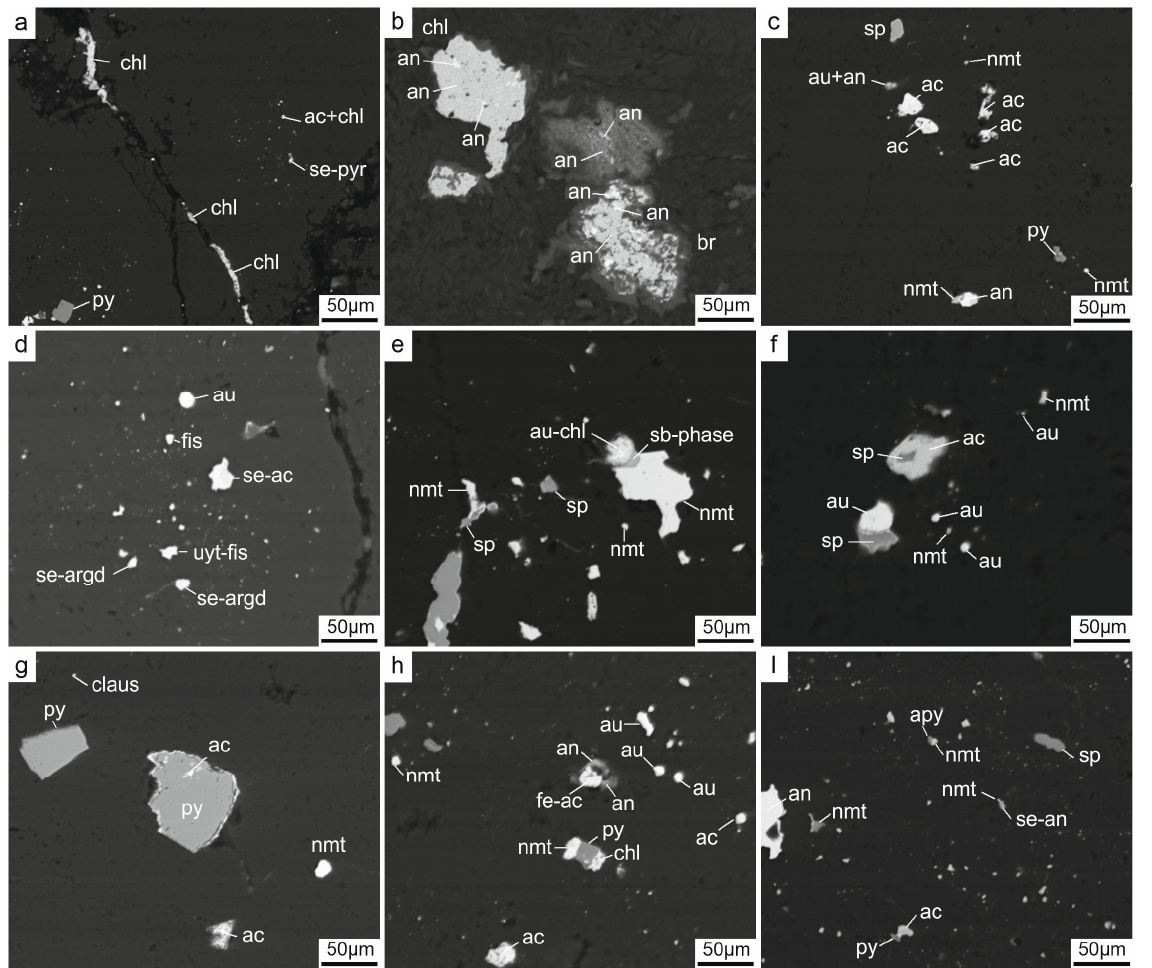
Figure 4. BSE (Backscattered electron) image of microscopic and submicroscopic particles of ore minerals in chalcedonic quartz: ( a )—chlorargyrite (chl), acanthite (ac), pyrargyrite (pyr) in fissures; ( b )—andorite (an), chlorargyrite (chl) and bro ‐ margyrite (br) in relatively large pores filled with anglesite and clay material; ( с )—native gold (au), acanthite (ac), nau ‐ mannite (nmt), sphalerite (sp), pyrite (py) in smaller pores; ( d )—acanthite (ac), argyrodite (argd), uytenbogaardtite (uyt) and fischesserite (fis) impregnation; ( e , f )—naumannite (nmt), chlorargyrite (chl), sphalerite (sp) and native gold (au) im ‐ pregnation; ( g )—pyrite (py) and acanthite (ac) impregnation; ( h )—native gold (au), naumannite (nmt), acanthite (ac) and pyrite (py) in smaller pores; ( I )—naumannite (nmt), acanthite (ac) and arsenopyrite (apy) in smaller pores.